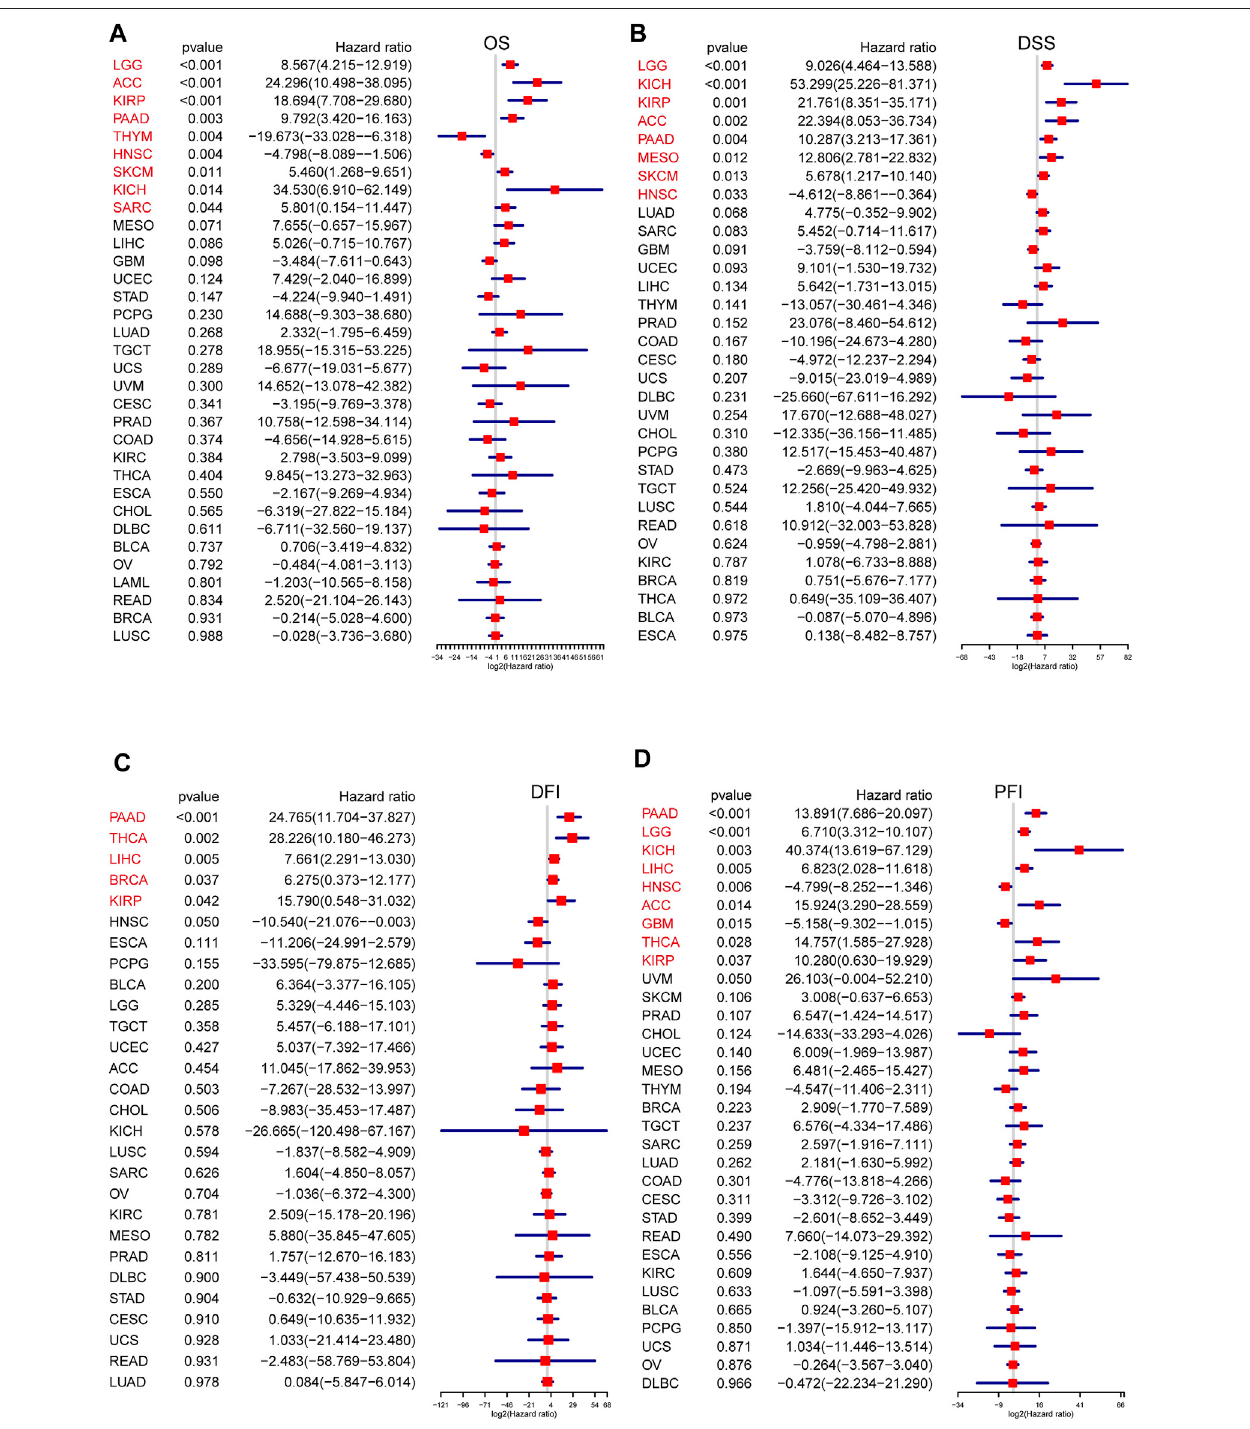
FIGURE 3 | The prognosis value of senescence score (SS) in each cancer type. The association of SS with prognosis in pan-cancer was evaluated based on Cox regression. (A) Correlations of SS with overall survival in each cancer. (B) Correlations of SS with disease-speci fi c survival in each cancer. (C) Correlations of SS with disease-free interval in each cancer. (D) Correlations of SS with progression-free interval in each cancer. Hazard ratio (HR) above 1 indicates an adverse prognosis, and the HR value less than 1.0 indicates a good prognosis. Tumors with signi fi cant p -values were shown in red font, and X-axis represents log2(HR). (Spearman correlation, p < 0.05 was considered signi fi